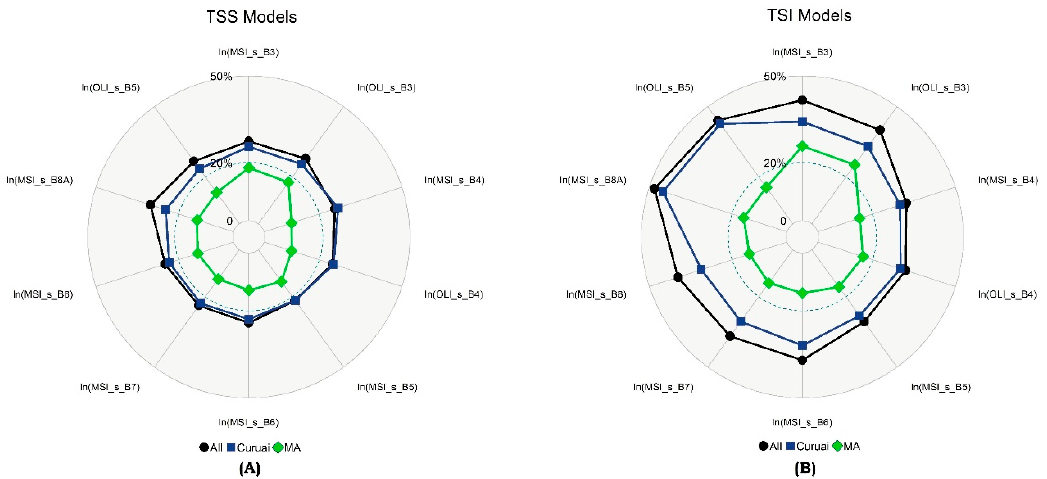
Figure 7. The MAPE values (%) obtained through a Monte Carlo simulation for R rs,sim_sat for both sensors using log models based on the Lake Dataset: ( A ) the log models for TSS and ( B ) the log models for TSI. The validation sample size for each lake: Curuai = 20 and Monte Alegre = 5. The R 2 and RMSE are in the Supplementary Files B. “All” at the bottom of the legend for TSS and TSI refers to the MAPE values for the All Dataset models (The values are in Table